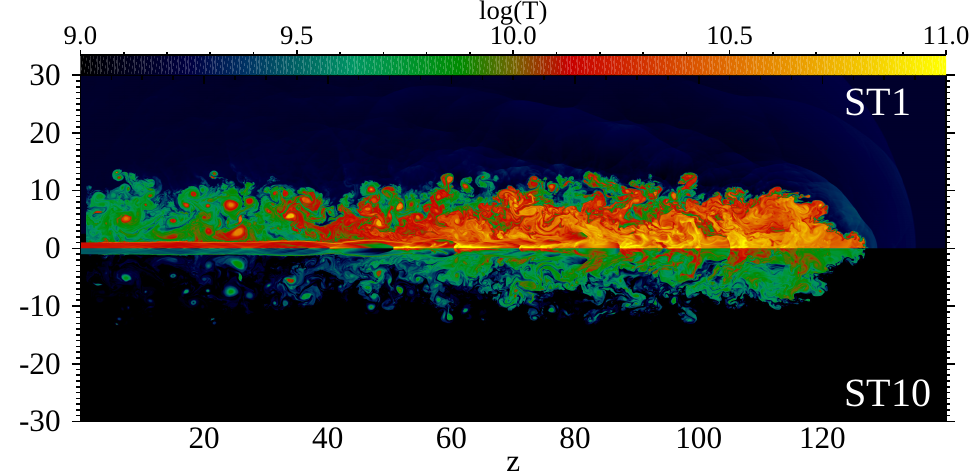
Figure 4. The electron temperature distributions with a log scale for model ST1 ( top ) and model ST10 ( bottom ) of model ST at t = 70 t 0 .